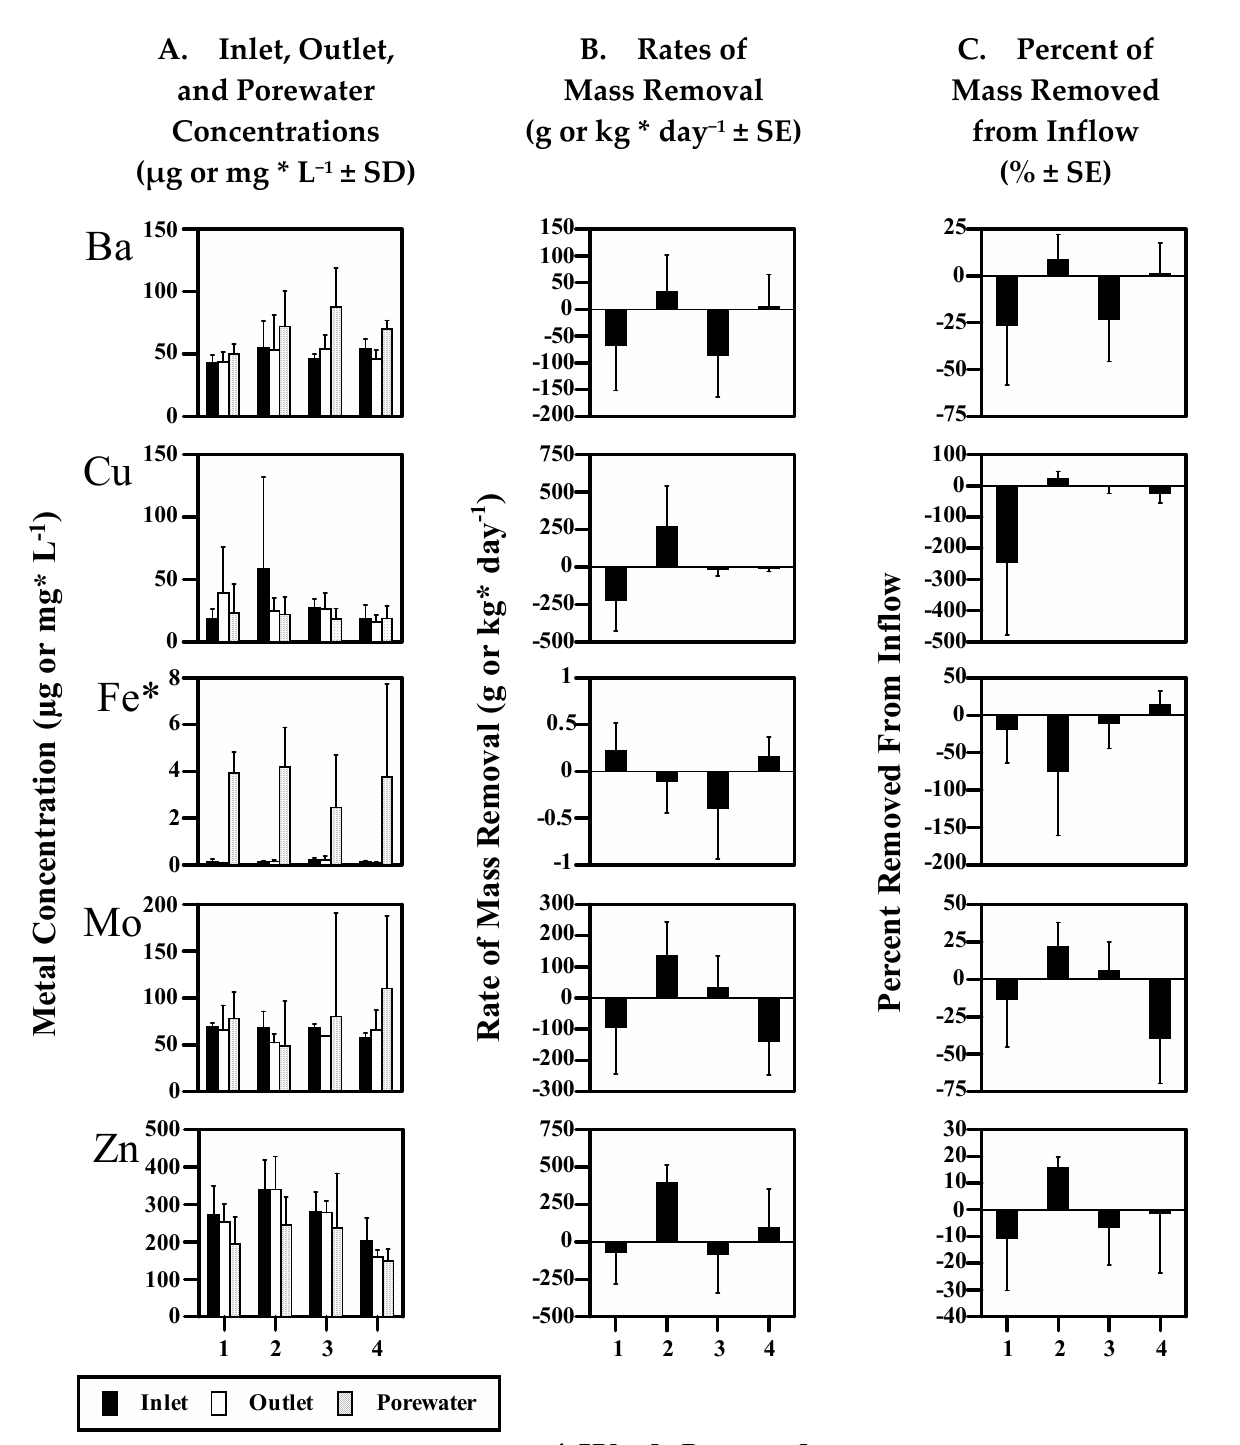
Figure 2. Zero-flux elements: Ba, Cu, Fe, Mo, and Zn. Periodic (4 week) mean values for: ( A ) Inlet, Outlet, and Porewater concentrations (µg or mg * L − 1 ± standard deviation; n = 4 for inlet and outlet; n = 15–30 for porewater); ( B ) rates of mass removal (g or kg * day − 1 ± standard error); and ( C ) percent of mass removed from inflow (± standard error) during the 16 week study period.